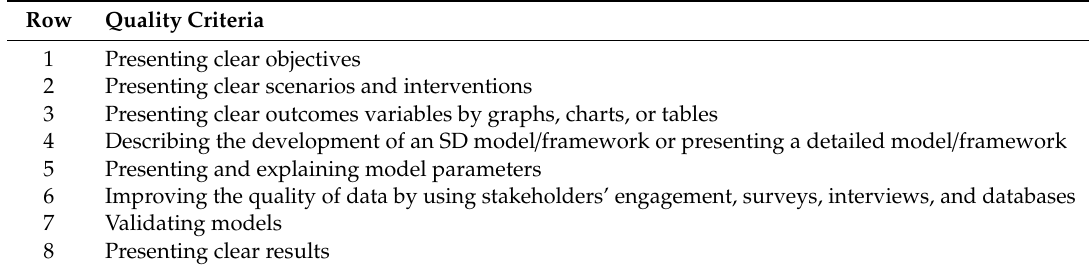
Table 5. List of quality